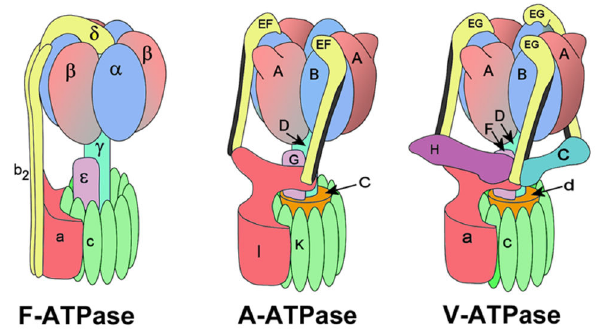
Figure 1. Subunit organisation in the rotary ATPase family. In the V-ATPase, the D/F/d/c-ring structure is the rotor, (AB) /(EG) /C/H/ a is the stator. Equivalent subunits within each 3 3 complex are in the same